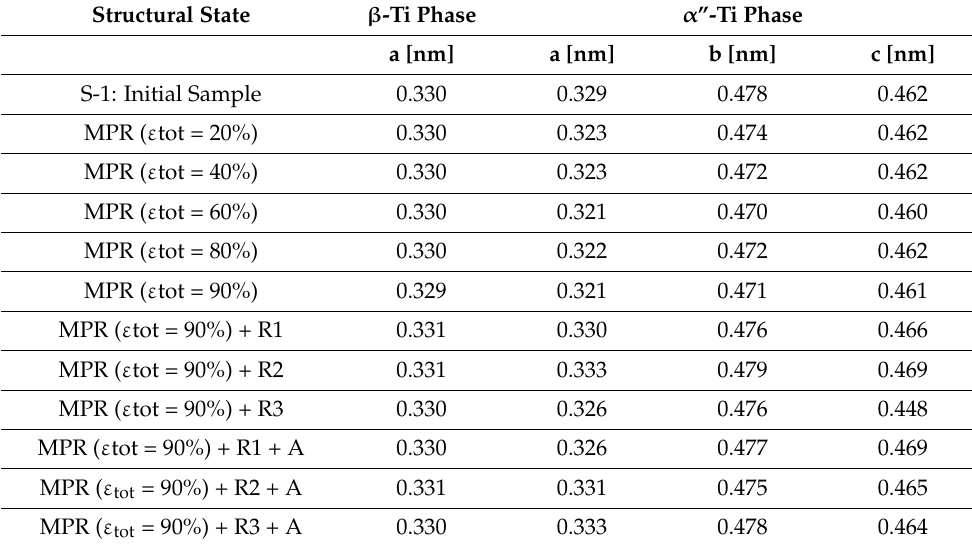
Table 1. Average crystalline network parameters corresponding to β -Ti and α (cid:48)(cid:48) -Ti phases identified for all analyzed stages of the studied alloy (MPR—multi-pass rolled sample; R—recrystallized sample; A—aged